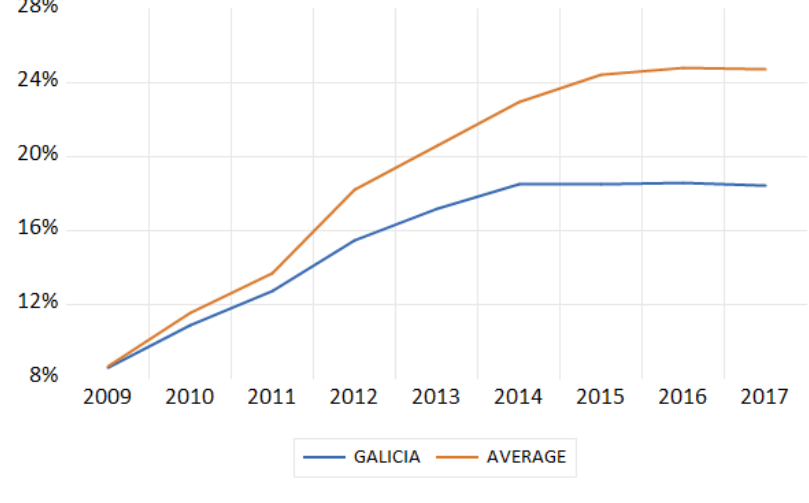
Figure 3 : Regional debt stock. Values in percentage of